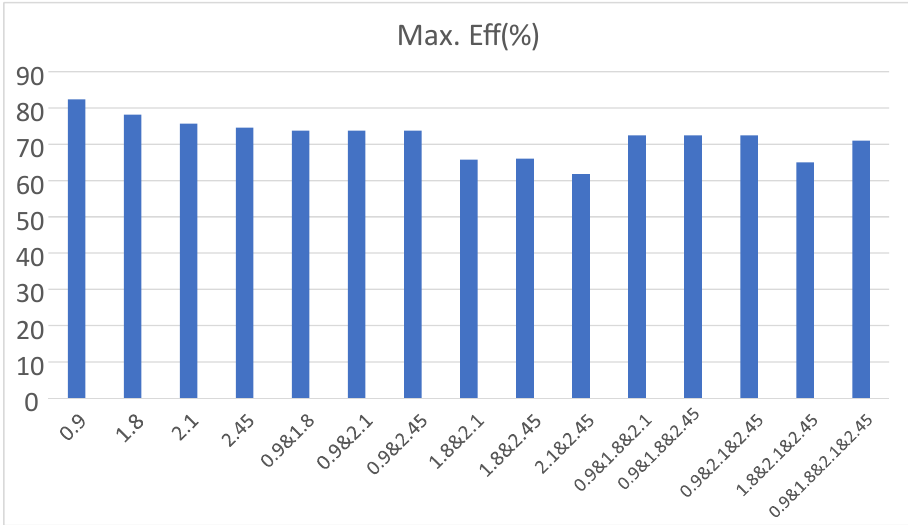
Figure 23. A chart for the conversion efficiency for single band, dual band, triple band and quad